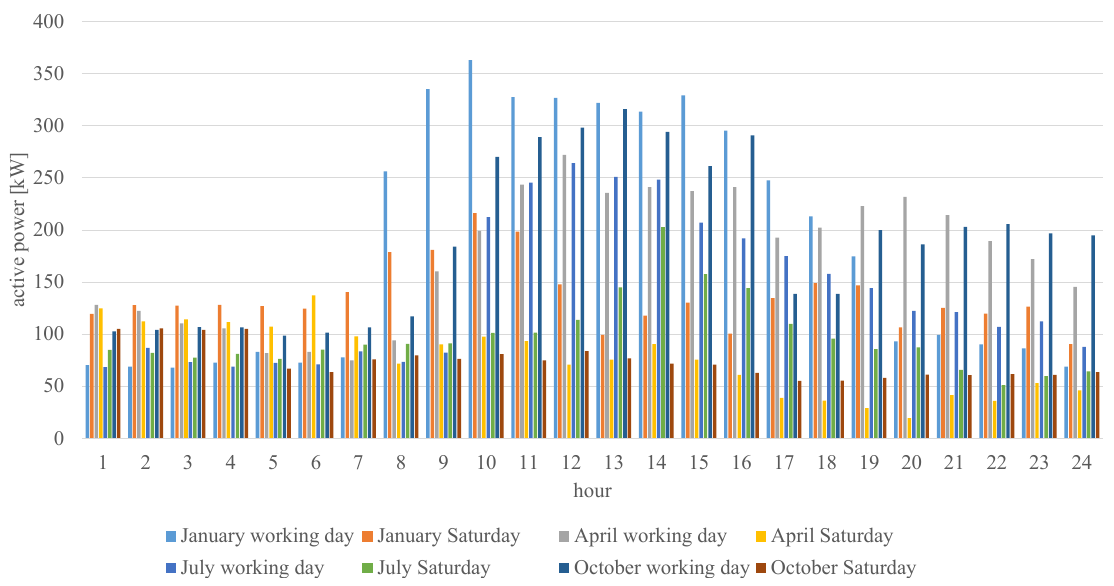
Figure 3. Load profile based on real data.